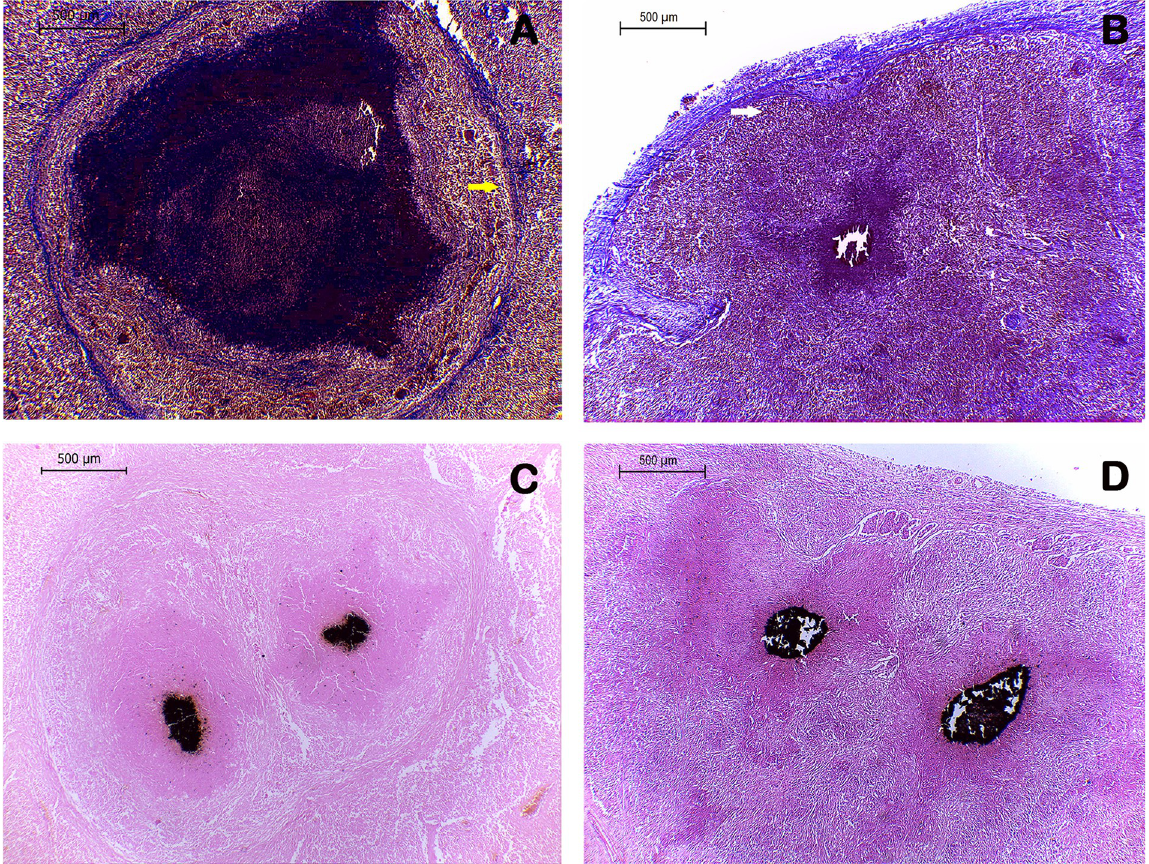
Fig 3. Calcium deposits in granulomatous lesions are independent of fibrous capsule presence in calves. (A) Masson’s trichrome stained section showing a stage IV granuloma surrounded by abundant fibrous tissue (yellow arrow) in a bovine adult. (B) Masson’s trichrome stained section showing a stage III-IV granuloma, without a fibrous capsule, but with surrounding disorganized collagen fibers in a calf. White arrow indicates connective tissue of the lymph node capsule as a reference. (C and D) Von Kossa staining, 200x, exhibiting stage IV (adult) and stage III-IV (calf) granulomatous lesions, with calcium deposits dyed in